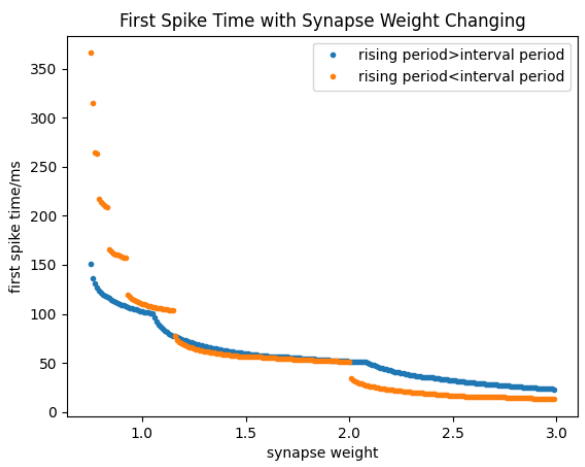
Figure 3. First spike time with synapse weight changing.